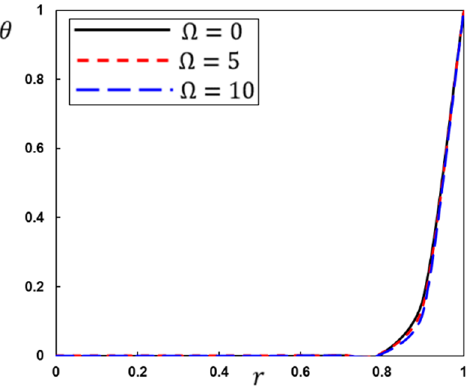
Figure 7. The temperature variation θ for different rotation parameter Ω .